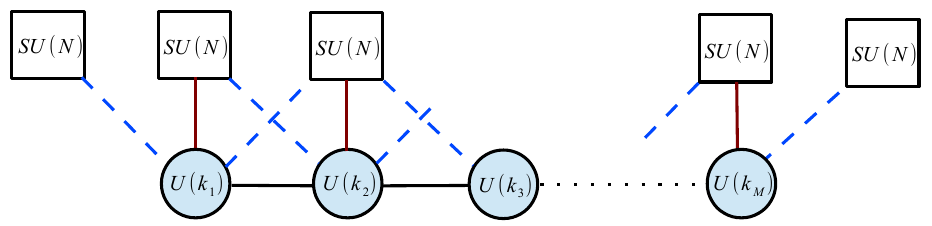
Figure 1 . Non-critical strings in M5 branes probing A N (cid:0)